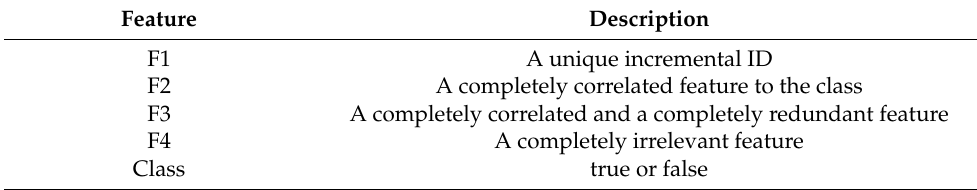
Table 2. Artificial dataset features.